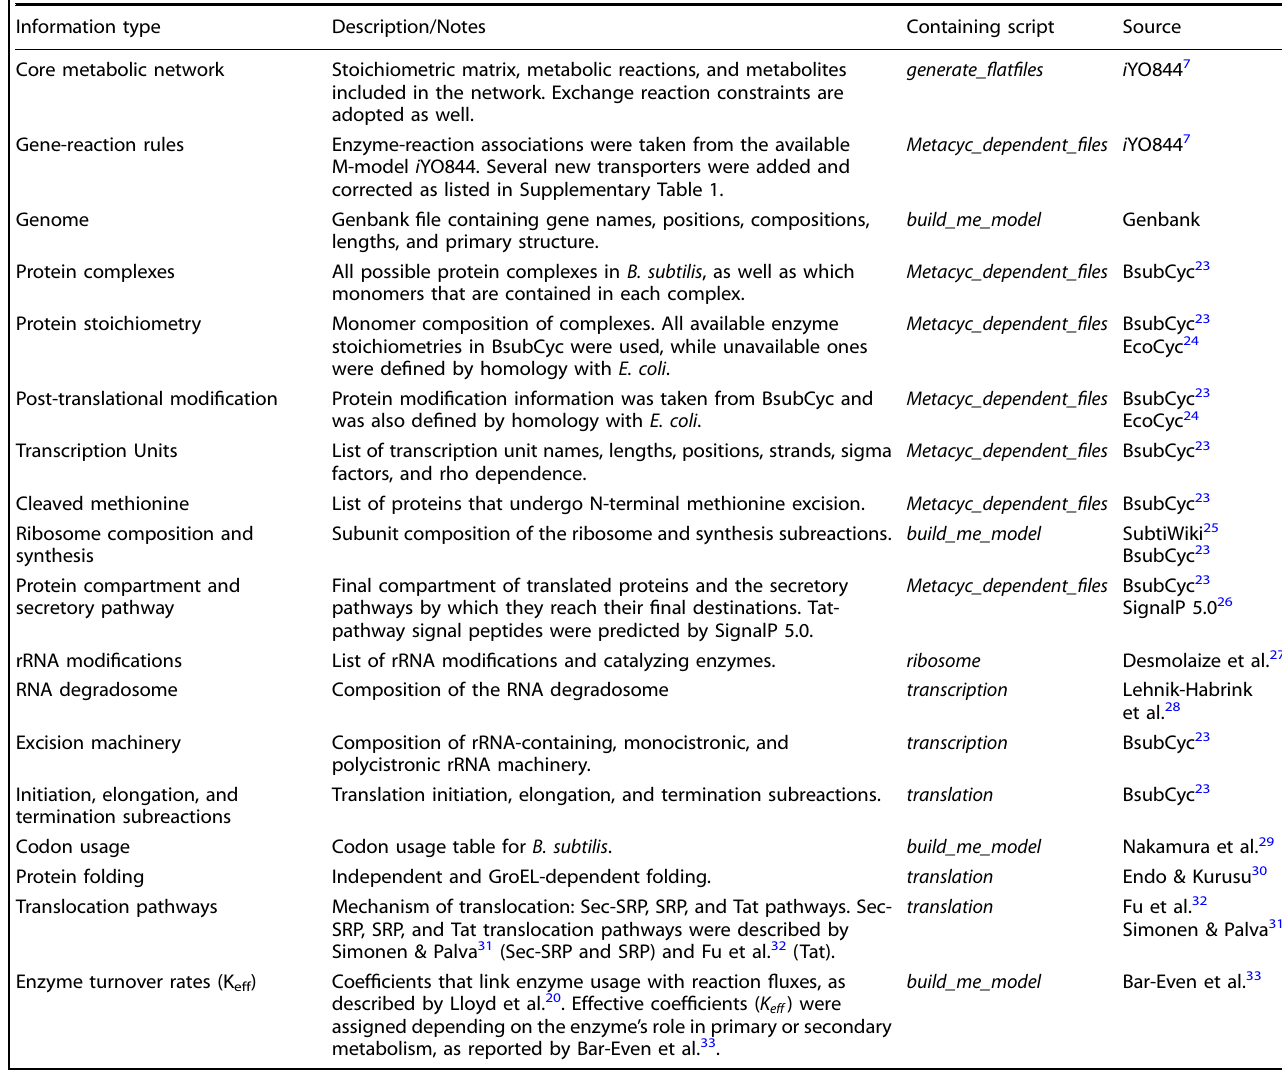
Table 1. Information included in the B. subtilis ME-model i JT964-ME.